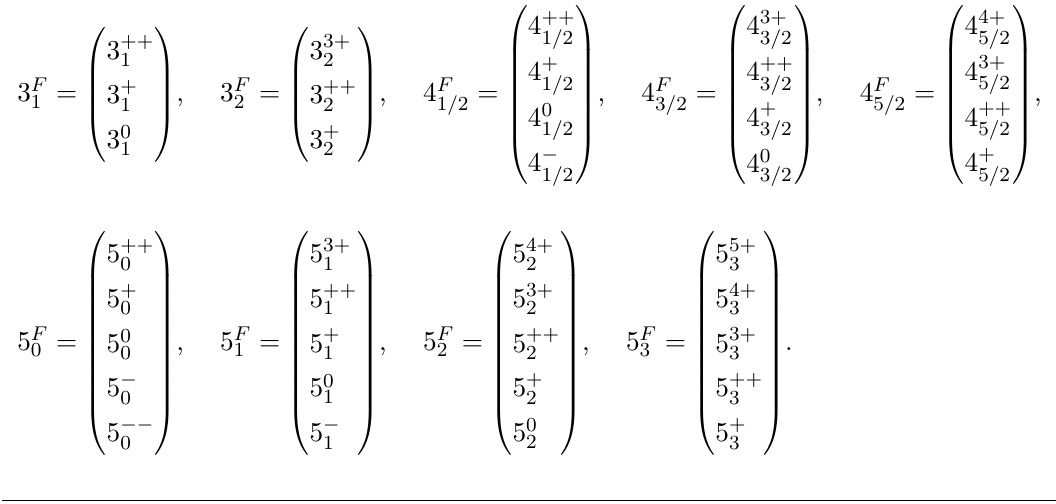
Table 1 . Exotic leptonic multiplets and their